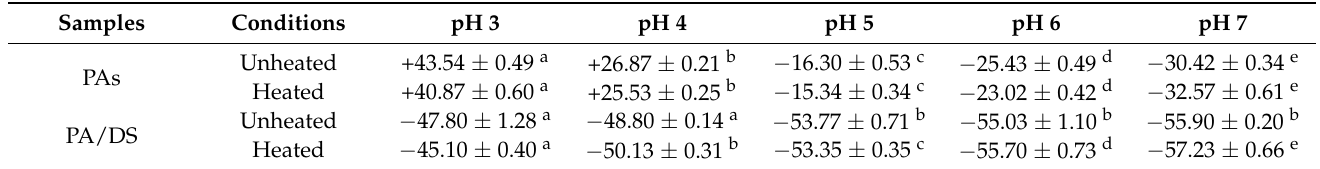
Table 2. Effect of pH and heat treatment on the zeta potential (mV) of emulsions stabilized by PAs and PA/DS.